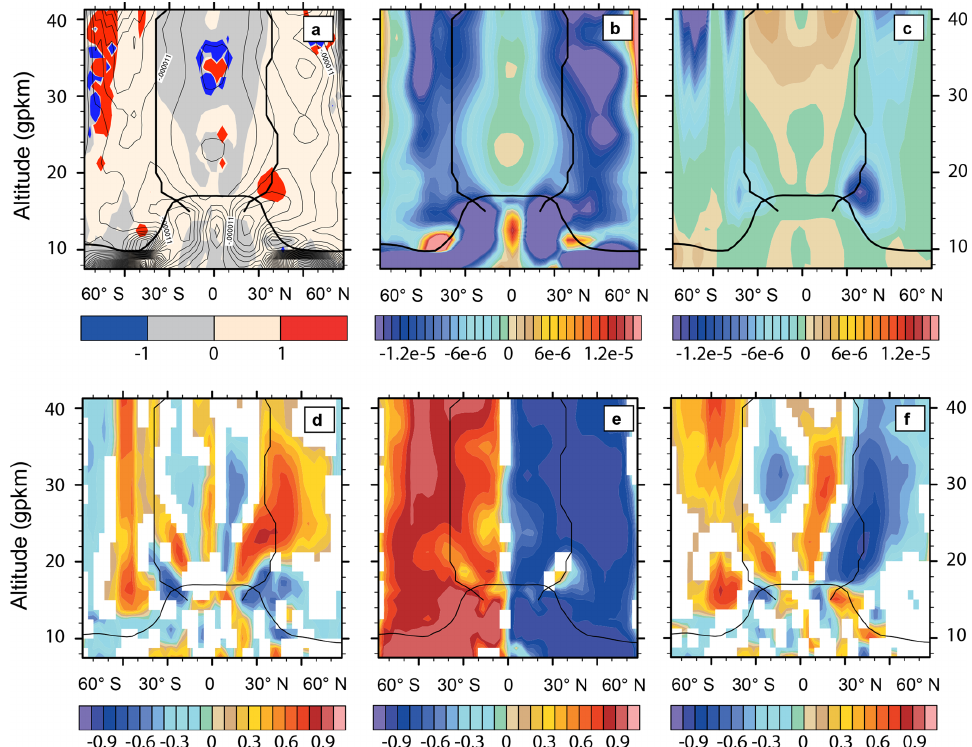
Figure A1. (a) GWD / EPFD ratio of the Ref period. The color scale is chosen so that the regions with the absolute value of zonal mean zonal GWD stronger than EPFD are highlighted. The contours show the total drag Ref climatology. (b) EPFD and (c) GWD climatology of the Ref period (units kgms − 2 ). Correlations between (d) GWD and EPFD, (e) EPFD and v ∗ , and (f) GWD and v ∗ in the Ref period. The vertical axis is in geopotential kilometers (gpkm). The plots are overlaid by the mean tropopause and turnaround latitude positions in the Ref period. Only regions with a statistical significance of correlations exceeding the 95% confidence level are